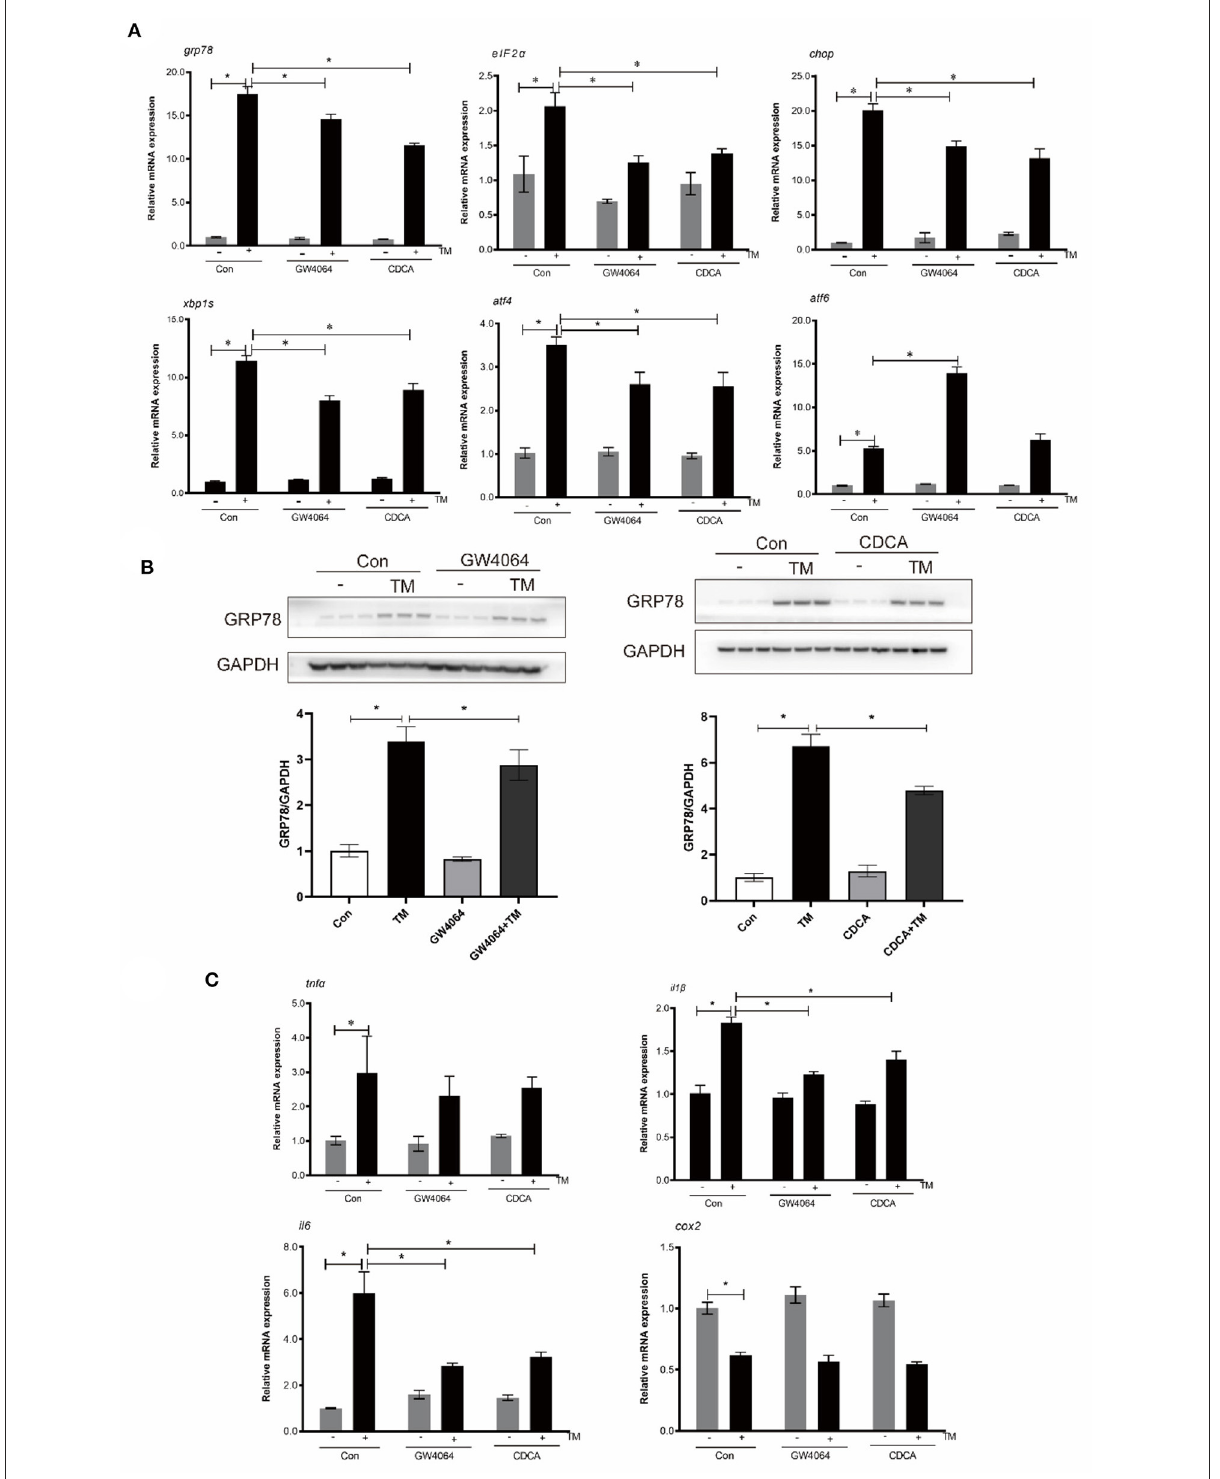
FIGURE4 Effects of activation of FXR by ligands on TM-induced ER stress and inflammation in croaker macrophages. (A) Gene expression and (B) protein level of ER-stress markers in macrophages after TM stimulation alone or with FXR agonists (GW4064 and CDCA). (C) Gene expression of pro-inflammatory genes in in macrophages after TM stimulation alone or with FXR agonists. *Different between two groups; P < 0.05 (means ± SEMs; n = 3; Student’s t